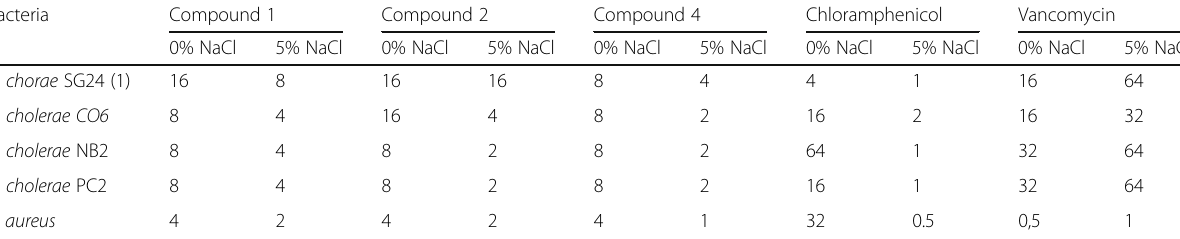
Table 2 Antibacterial activities in terms of MIC ( μ g/mL) of compounds 1, 3 and 4 under osmotic stress condition against bacterial strains